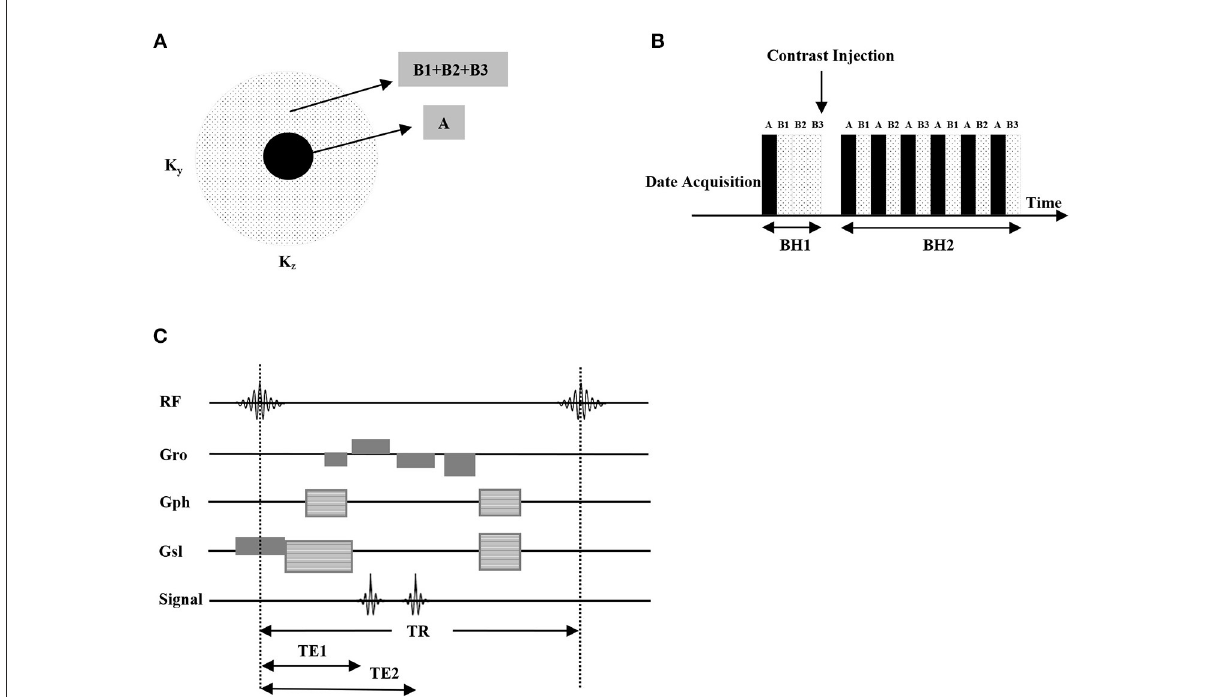
FIGURE1 DISCO pseudo-random variable density k-space segmentation (A) , the central block region was acquired always and the outer pseudorandom subsampled dotted regions were interleaved (data acquisition schedule is AB1AB2AB3AB1...) (B) . The pulse sequence chart of the proposed DISCO sequence, high receiver bandwidths ( ± 83.3kHz) enabled the acquisition of opposed-phase and in-phase echoes at TE1 (about 1.1ms) and TE2 (about 2.2ms) in individual TR, greatly reducing scan times, which is optimal for 3T MRI (C) .